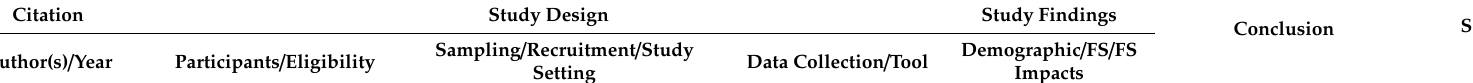
Table 2. Literature review of the included studies (n =